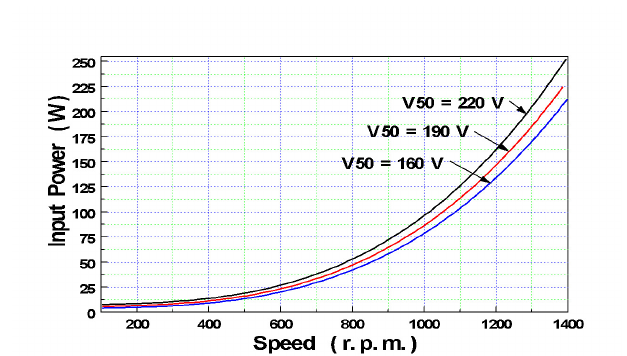
Fig. 6. Variation of the input power with speed (computed).